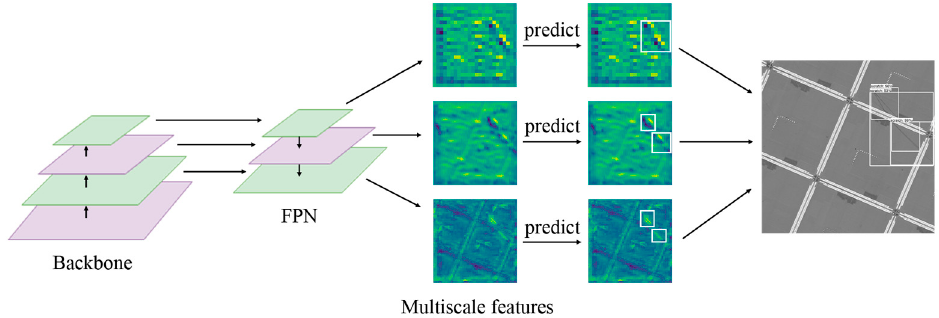
Figure 4. Multiple-detection problem caused by discontinuous